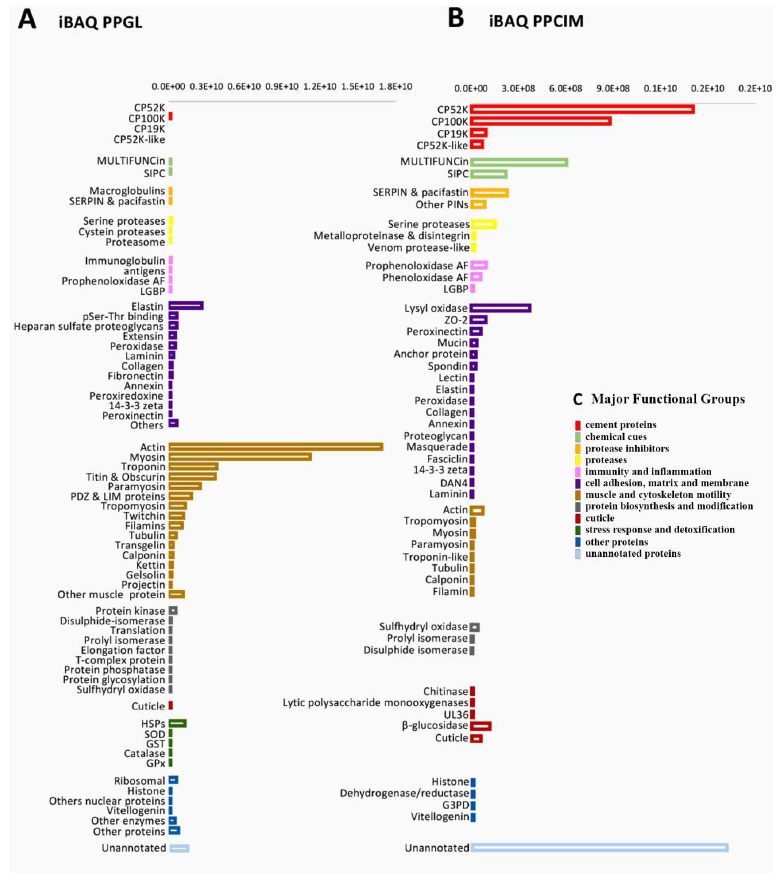
Figure 4. Relative protein abundance within ( a ) the gland proteome (PPGL); and ( b ) cement proteome (PPCIM) of the barnacle Pollicipes pollicipes . Absolute protein abundance of broad protein families, shown as a single bar, was obtained using an intensity-based absolute quantification (iBAQ) score calculated by MaxQuant. The horizontal scales of bars differ between samples (PPGL and PPCIM), being the highest in the gland proteome. Major functional groups ( c ) corresponding to the protein families identified are represented by color bars on the right side. Int. J. Mol. Sci. 2020 , 21 , x FOR PEER REVIEW